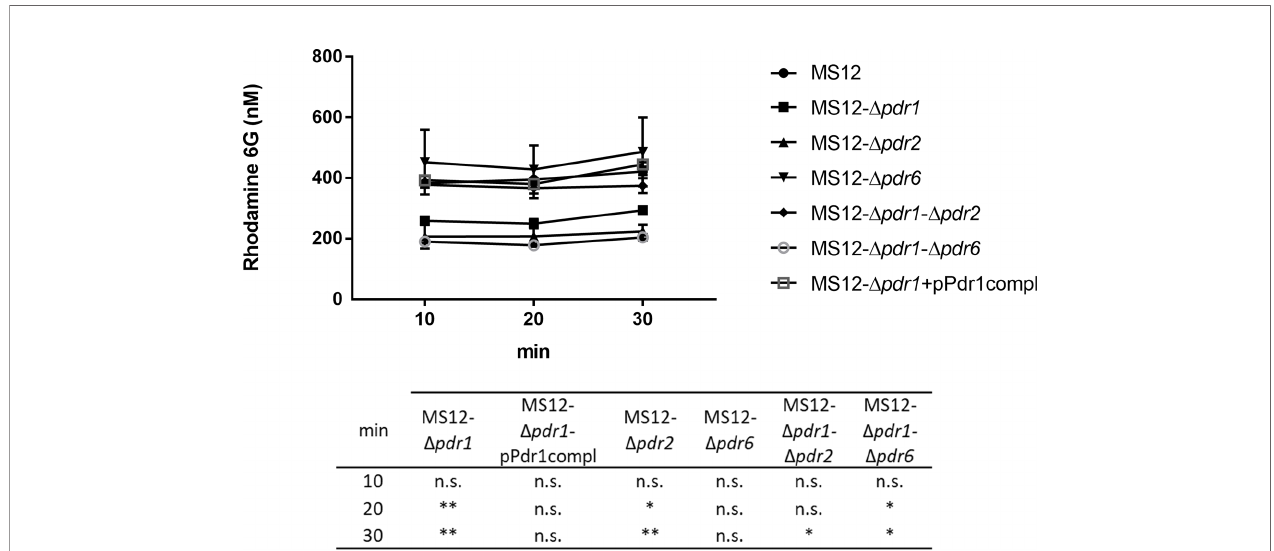
FIGURE 7 | Measurement of the R6G ef fl ux activity. After uptake of rhodamine 6G, fungal cells were resuspended in PBS supplemented with 2 nM of D-glucose. Values followed by * and ** signi fi cantly differed from the corresponding value of the MS12 strain according to the two-way Anova (*p < 0.05; **p < 0.01), n.s. is non-signi fi cant.